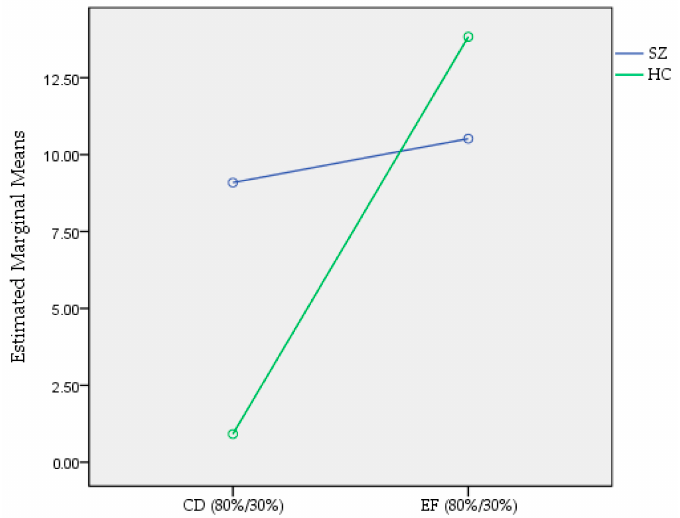
Figure 4. The effect of interaction of group (patients with SZ and HC subjects) and the difference between the first 10 and last 10 trials of the CD (80%/30%) and EF (80%/30%) conditions of the training phase of the IPST. Green color refers to HC participants and blue color refers to patients with